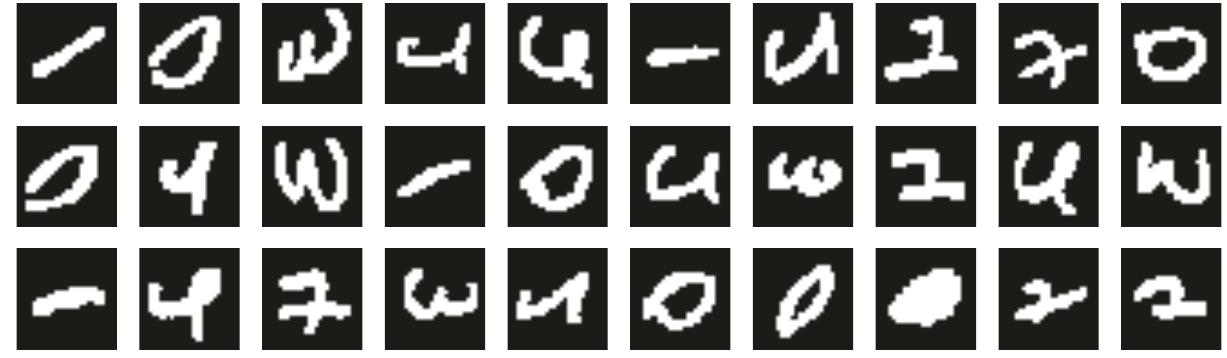
Figure 6: Some images from the MNIST database.